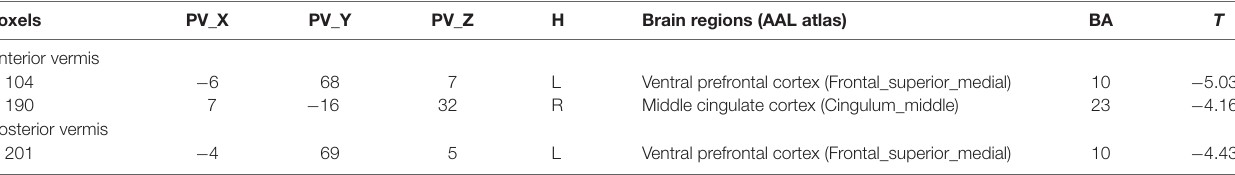
TABLE 2 | Detailed information for clusters showing group connectivity differences in BD at the given threshold (cluster size > 297 mm 3 , and P < 0.00014).